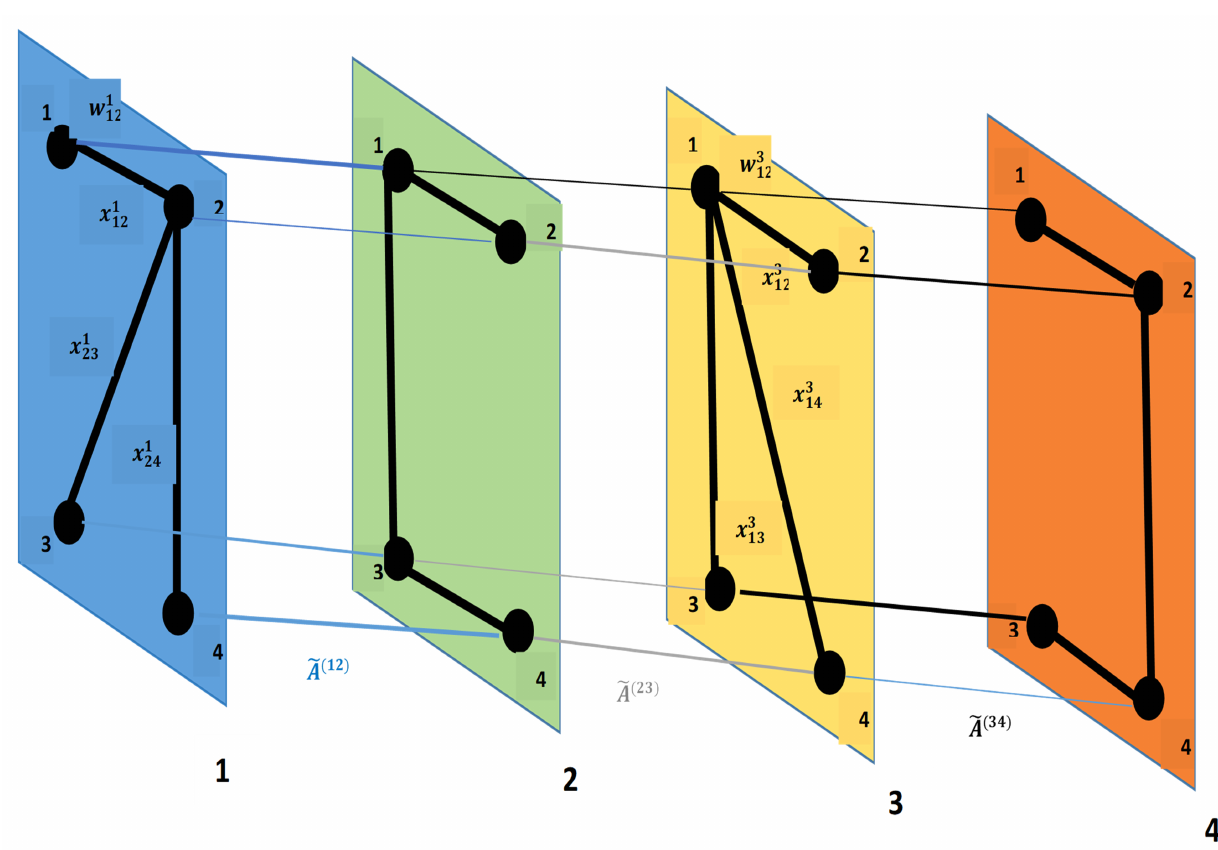
Figure 1. A dynamic multilayer